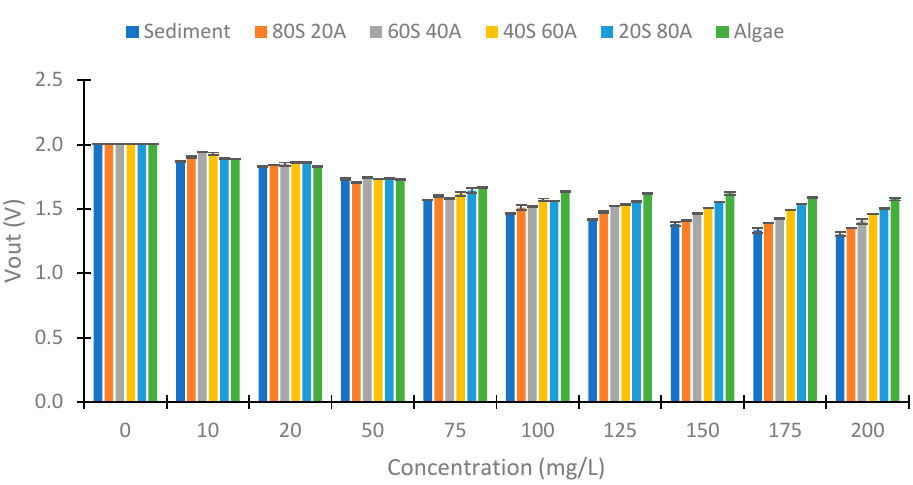
Figure 16. Vout with the use of green light at voltage divider LDR at 90°.